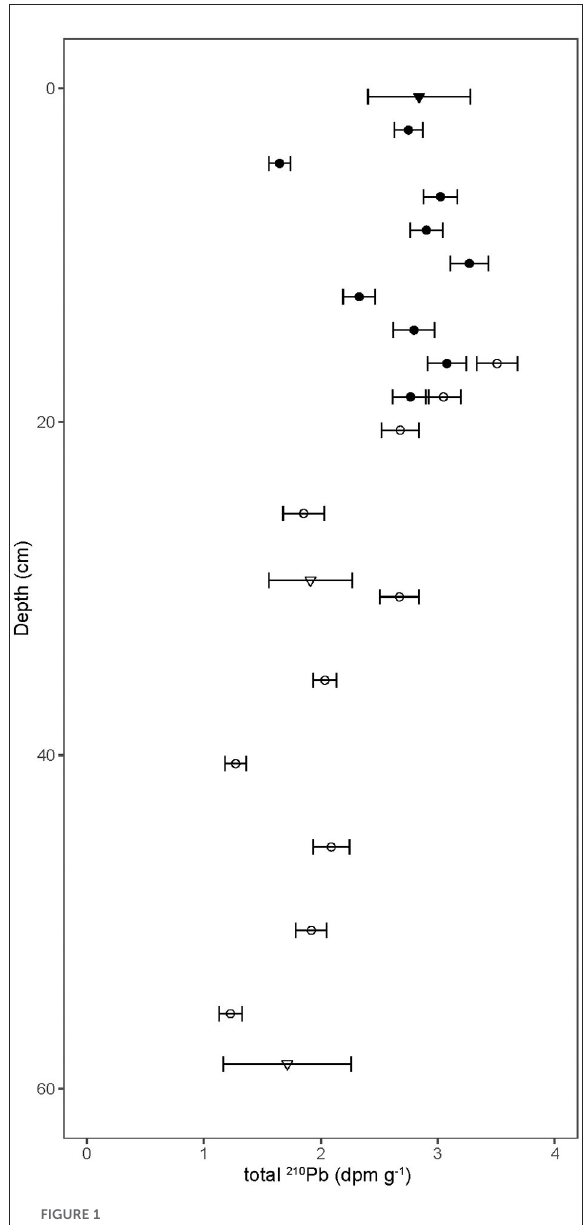
FIGURE1 210 Pb activity in bat guano as a function of depth, where the bottom of the core reached the cave floor at 60cm depth. Error bars show ± 1 SD. The MLA core (filled circles) and the MLB core (open circles) show good agreement as do 210 Pb activities derived by 210 Bi analysis (triangles) and 210 Po analysis